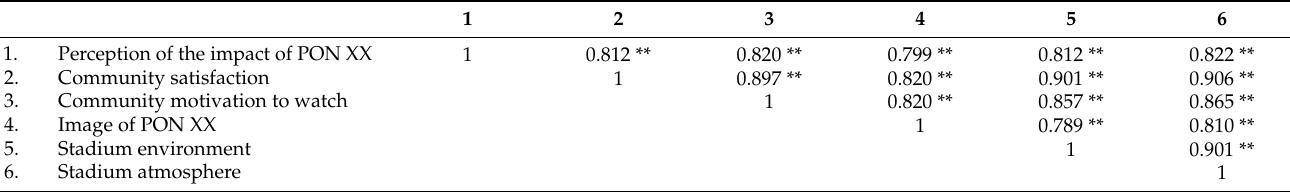
Table 5. Correlation test results between